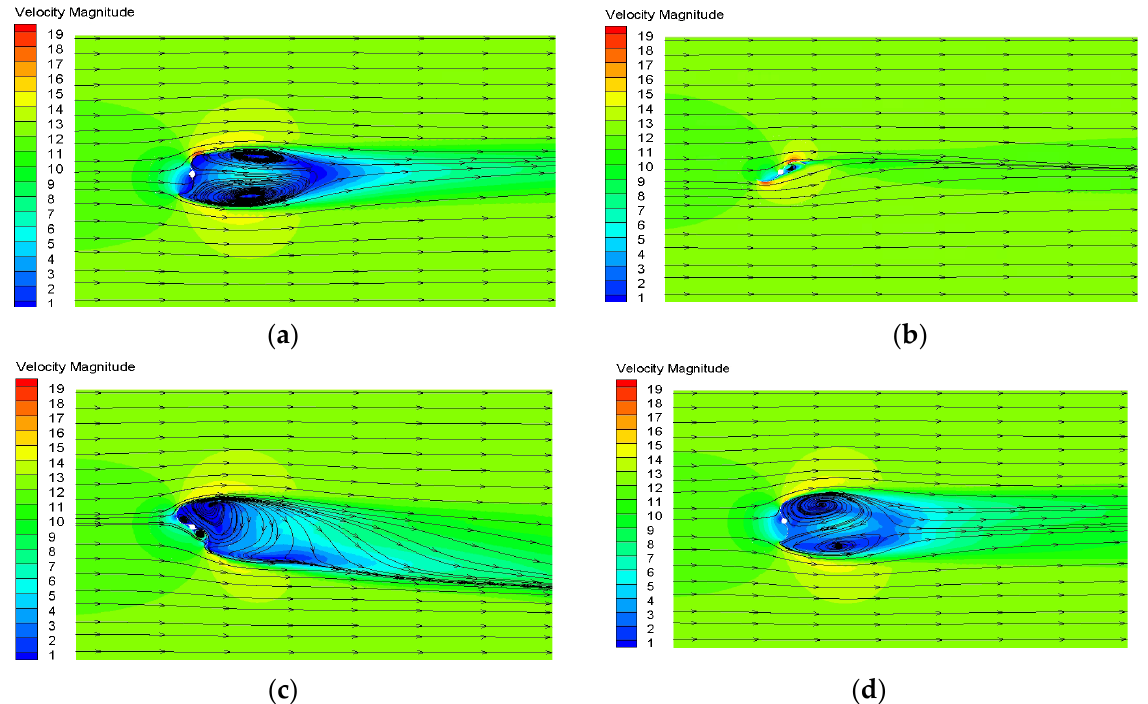
Figure 11. Velocity and streamlines nephograms of wind turbine. ( a ) 60° basic wind turbine (Z = 0). ( b ) 60° spiral wind turbine (Z = 0). ( c ) 120° basic wind turbine (Z = 0). ( d ) 120° spiral wind turbine (Z = 0).